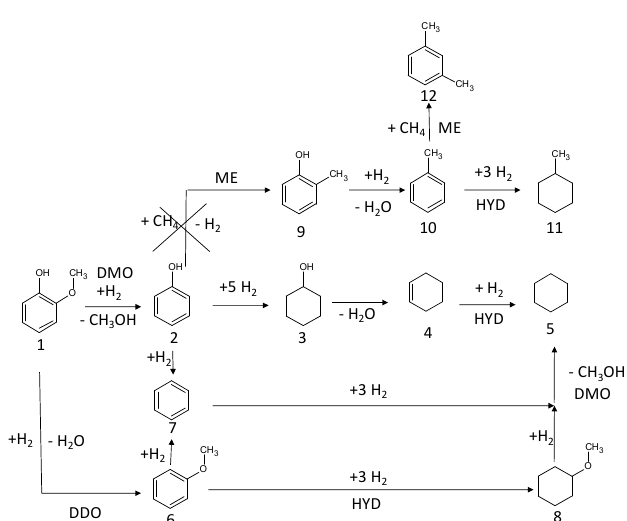
Figure 6. Reaction scheme for guaiacol HDO at 300 °C under 50 bar hydrogen over ReOx/CNF catalyst adapted from reference [37]. Notation: 1. guaiacol, 2, phenol, 3. cyclohexanol, 5. cyclohexene, 5, cyclohexane, 6. methoxybenzene, 7. benzene, 8. methoxycyclohexanol, 9. O-cresol, 10. toluene, methylcyclohexne and 11. xylene. DMO denotes demethoxylation, DDO direct deoxygenation, ME methanation and HYD hydrogenation.